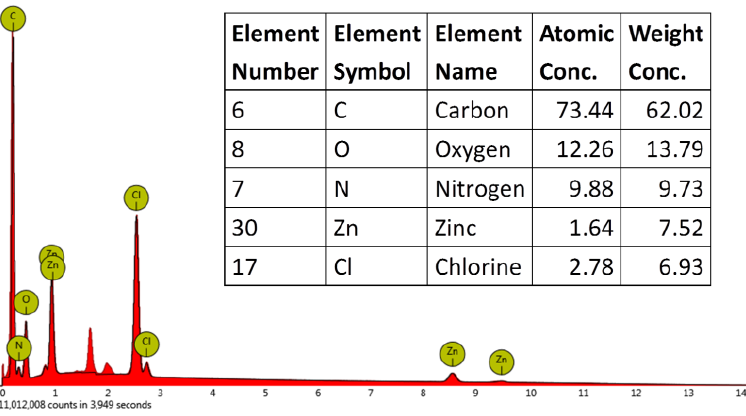
Figure 15. SEM images of gel 1 from 1,4-dioxane after the addition of 1.0 eq. of Zn 2+ .